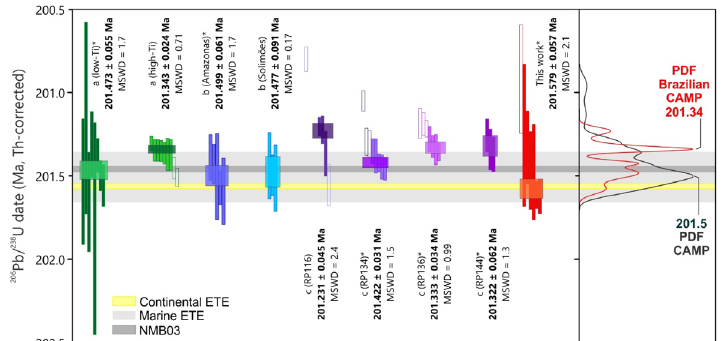
Figure 6. Revised ages for South American CAMP rocks corrected to the same Th/U value of 5.0 ± 0.5. (a)—Ref. 2 ; (b)—Ref. 3 ; (c)—Ref. 10 and this work. Continental and marine ETE timing are from Ref. 6 and Ref. 7 , respectively. Age for the NMB03 sample is the same shown in Fig. 5b. Asterisk (*) indicates samples from low-Ti (< 2%wt. TiO 2 ) magma types, presumed as causers of the end-Triassic extinction (ETE) event. PDF (probability density functions) curves are derived from U–Pb ages, black is relative to the entire CAMP magmatism (minus South American samples), red is derived from South American CAMP dates shown in this